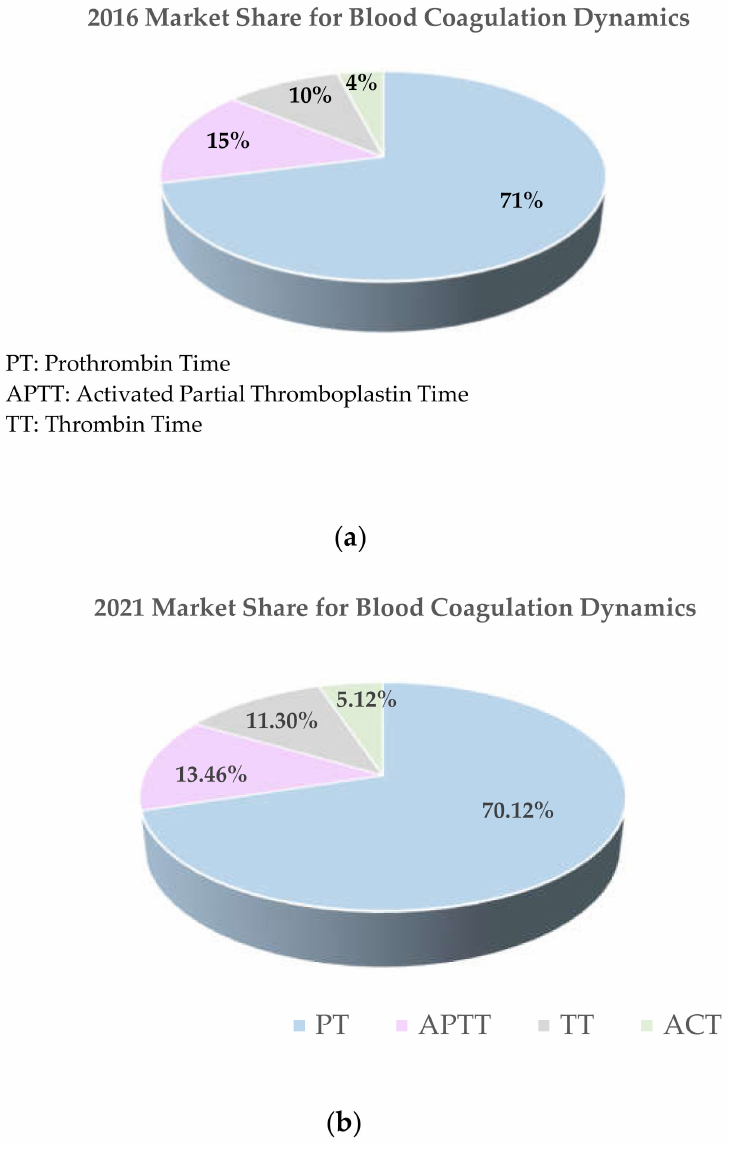
Figure 1. Global coagulation analyzer market share ( a ) in 2016 ( b ) predicted for the year 2021 (Reproduced from the data provided by ref.